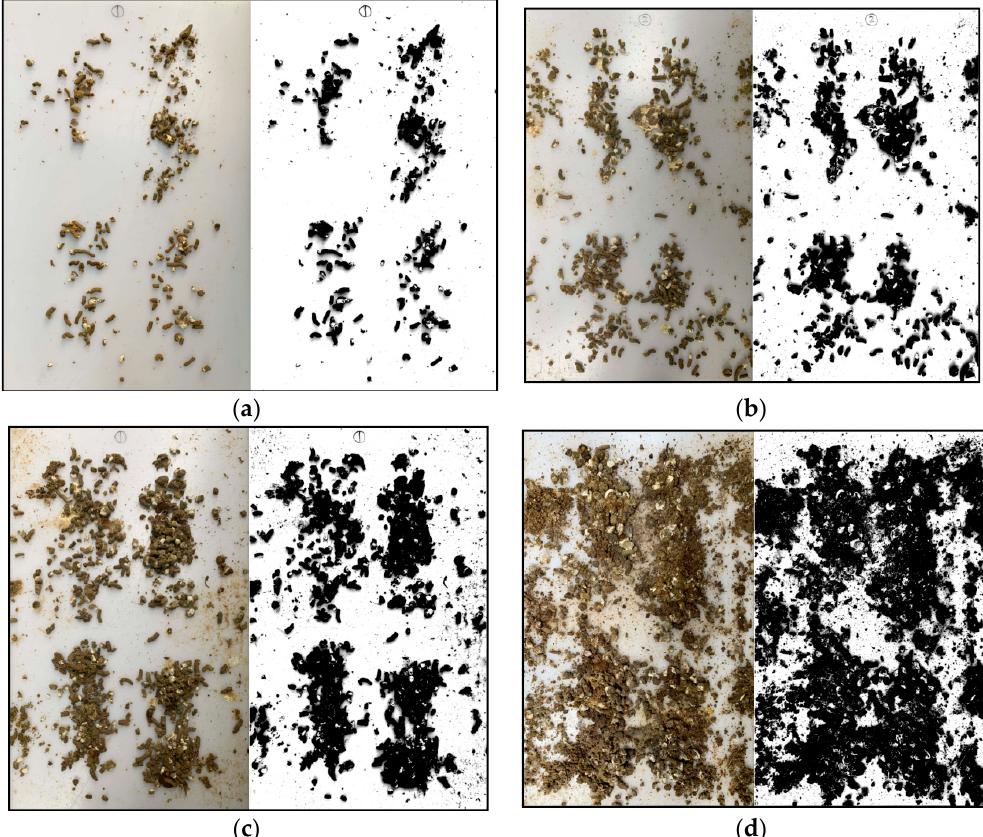
Figure 4. Examples of original photographs (left) and binary images (right). The photographs were taken at the ( a ) 3rd hour, ( b ) 8th hour, ( c ) 11th hour, and ( d ) 30th hour after the start of the experiment. The corresponding objects coverage proportion for ( a – c ) and ( d ) is 11.76%, 25.82%, 36.01%, and 68.63%,